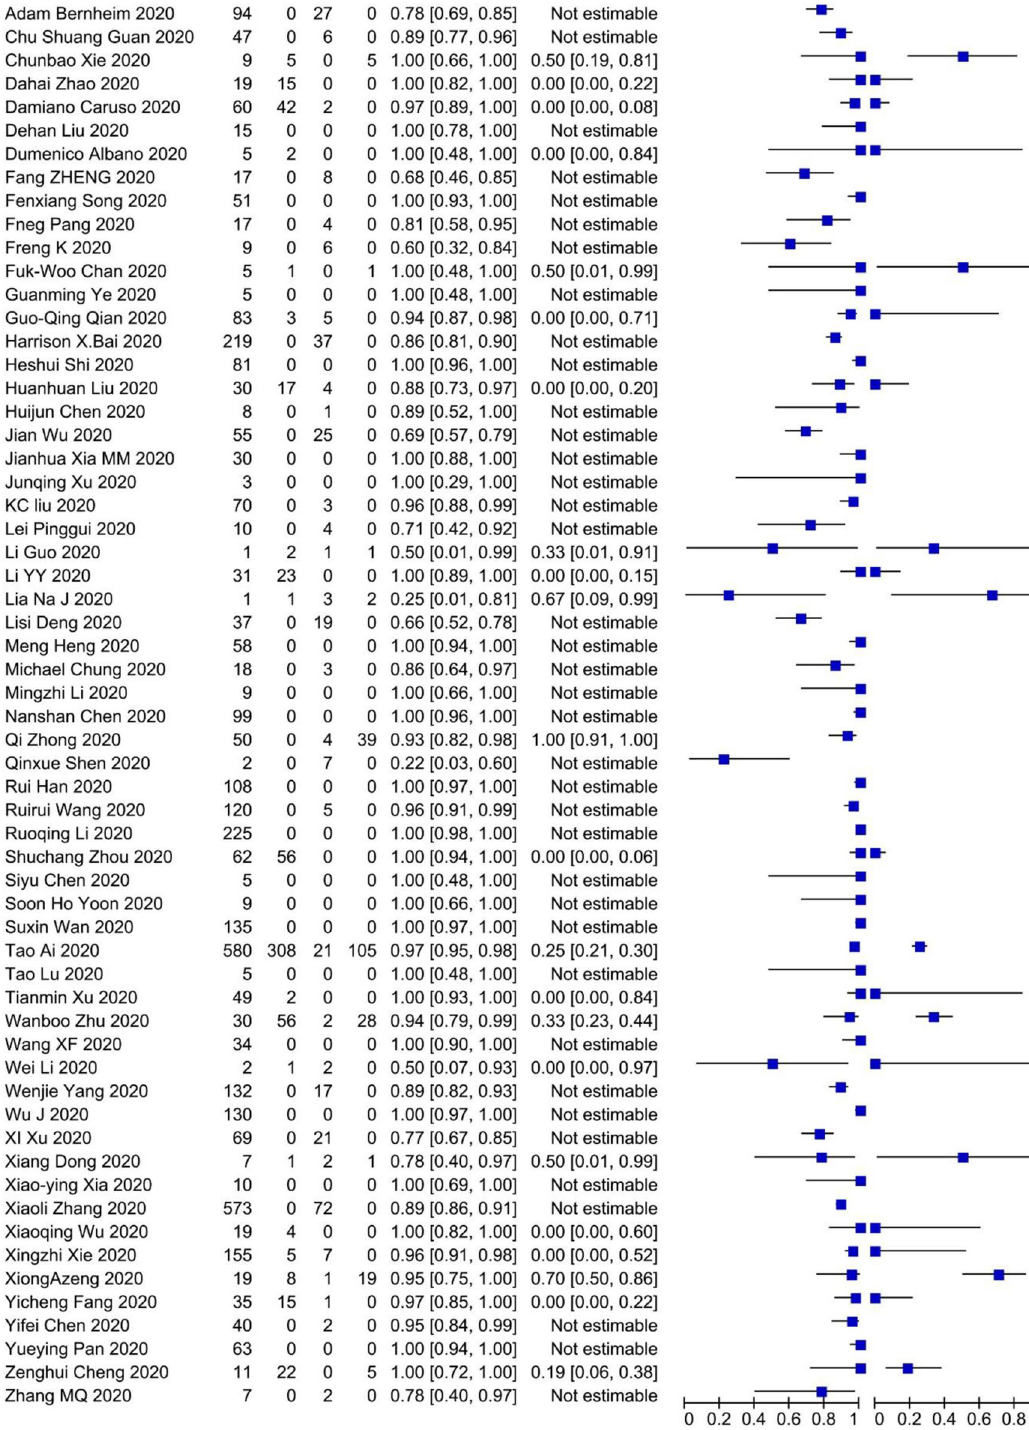
Figure 2. Sensitivity and specificity of 60 included